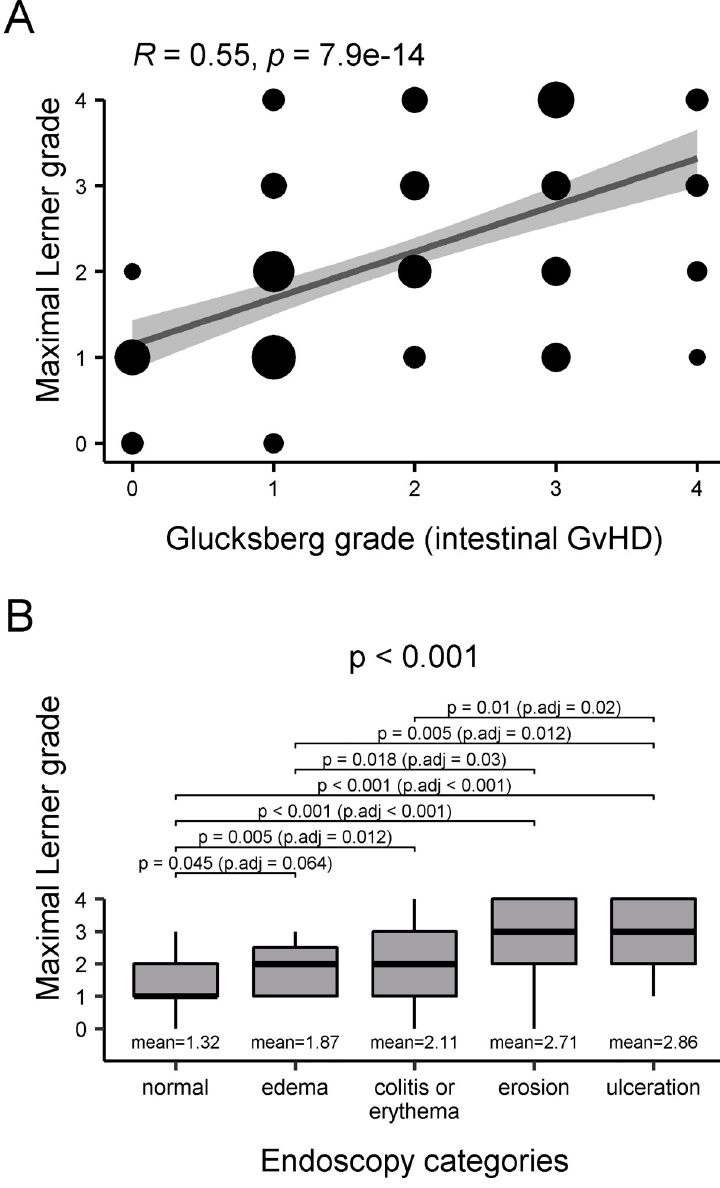
Fig 2. Correlation between the histological maximum Lerner grade of the samples obtained in the biopsy series with each of the Glucksberg grade of intestinal graft-versus-host disease (GvHD). Diameters of the dots correlate with number of cases linearly (A). Endoscopic findings in patients with acute GvHD (B).